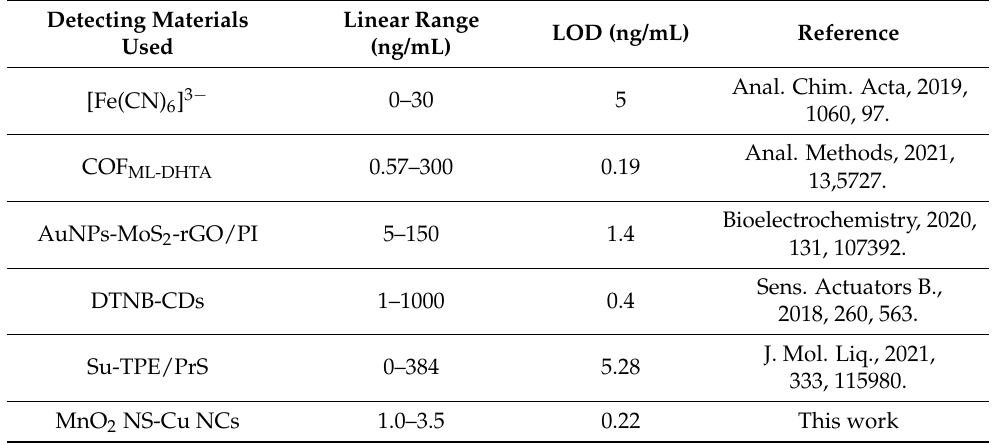
Figure 4. ( a ) Fluorescence emission spectra of the detection platform after adding different concentra- tions of paraoxon. Relationship between the ratio of fluorescence intensities and the concentrations of paraoxon showing as inset; ( b ) ratio of fluorescence intensities of the detection platform by adding different types of OPs; ( c ) evolution of the ratio of fluorescence intensities of the platform as a function of OPs concentrations; ( d ) selectivity test of the detection platform against different interference species, as presented on the frame. All the fluorescence intensities were recorded at 423 nm, under the excitation of 380 nm. Table 2. Comparison of the detection performances of our assay for OPs with recently reported